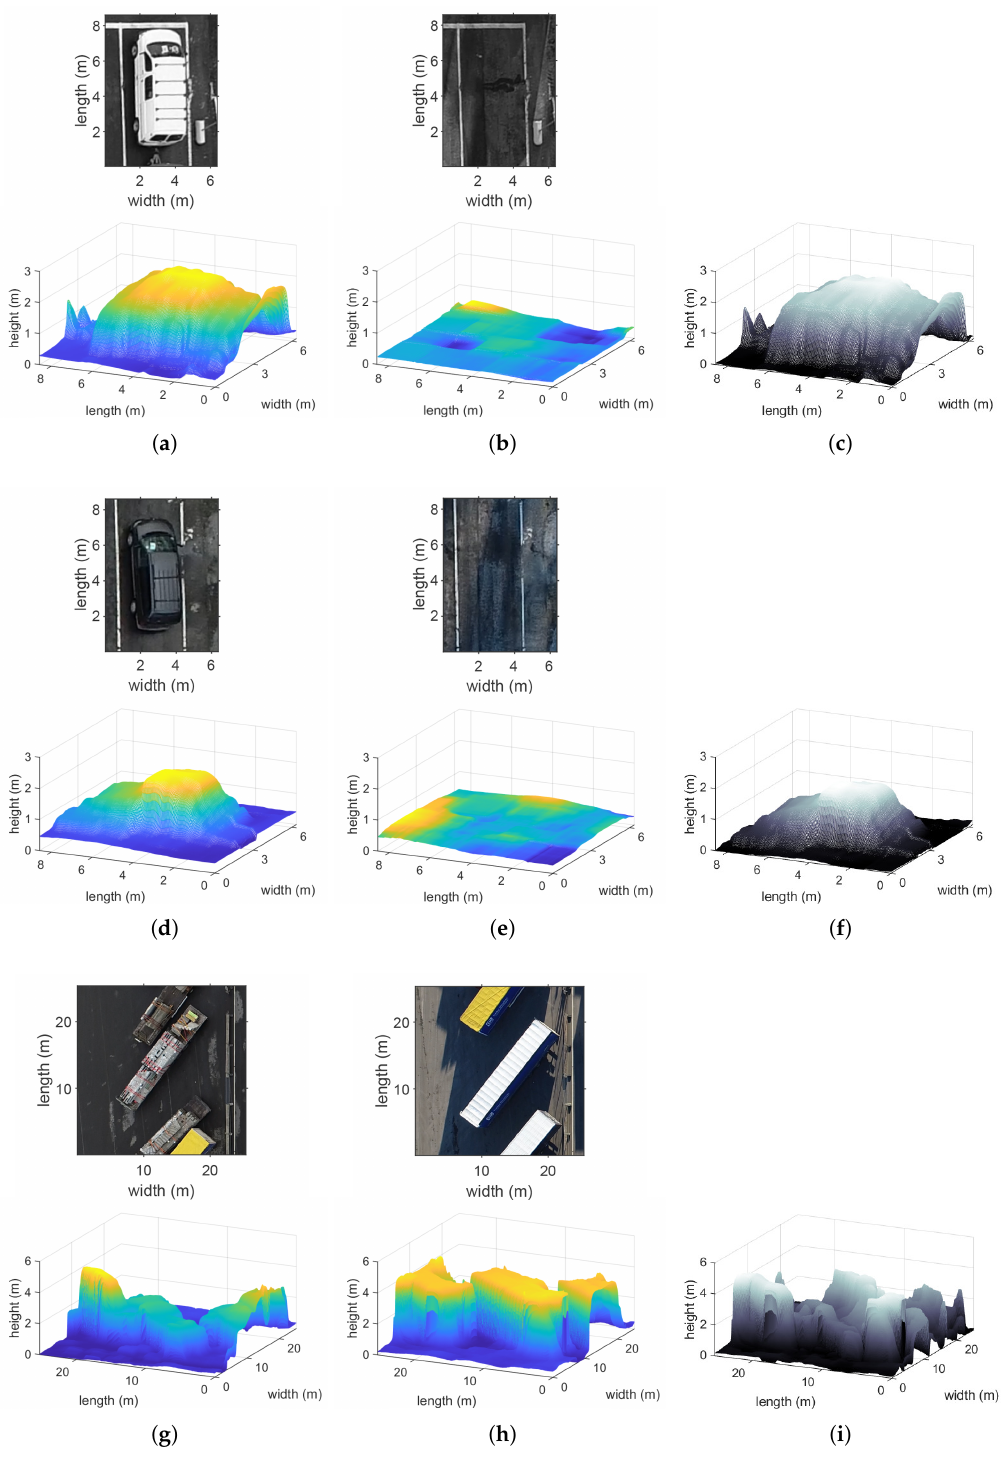
Figure 8. Change detection in three regions using generated 3D feature maps: ( a , d , g ) day 1; ( b , e , h ) day 2; ( c , f , i ) 3D comparison model E showing the differences in height properties of the respective